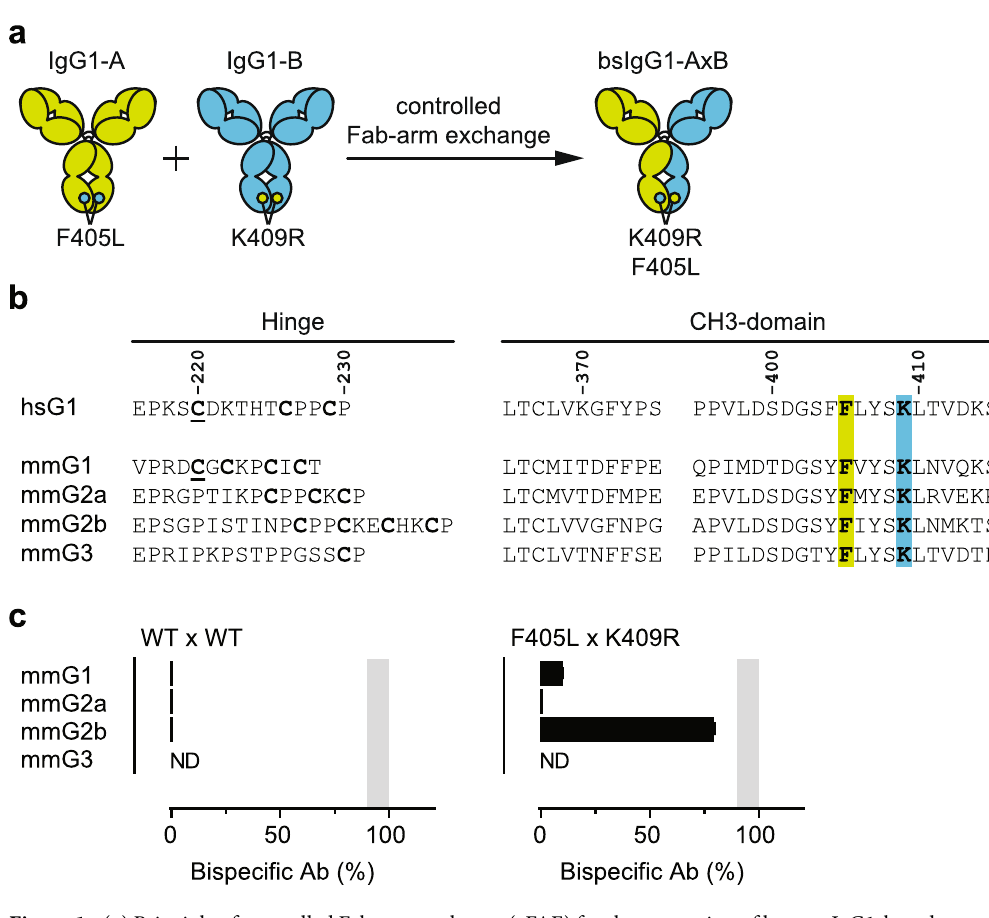
Figure 1. ( a ) Principle of controlled Fab-arm exchange (cFAE) for the generation of human IgG1-based bispecific antibodies. IgG1-A and IgG1-B molecules containing matching point mutations in their CH3 domains, F405L and K409R (EU numbering) 23 respectively, are separately expressed and mixed in a 1 to 1 ratio under mild reducing conditions (5 h at 31 °C using 75 mM 2-MEA). This allows in the recombination of half-molecules driven by the matched mutations that enable dissociation of half-molecules in IgG1-A and IgG1-B and favor heterodimerization into IgG1-AB molecules. ( b ) Amino acid sequence alignment of human ( H . sapiens ; hs) and mouse ( M . musculus ; mm) hinge and CH3 regions. EU-numbering convention is used to annotate the amino acid residues. Cysteine residues in the hinge region involved in HC-HC linkage and LC-HC pairing (underlined) are indicated in bold. Residues F405 and K409 are indicated in green and blue, respectively. ( c ) Efficiency of cFAE as measured by HIC of mixtures of 2F8-derived and 7D8-derived mmIgG1, mmIgG2a or mmIgG2b parental antibodies, containing the indicated mutations (above panels). Data represent mean ± SEM of at least two separate experiments. ND = not done (due to limited sample availability). Shaded area represents 90–100%